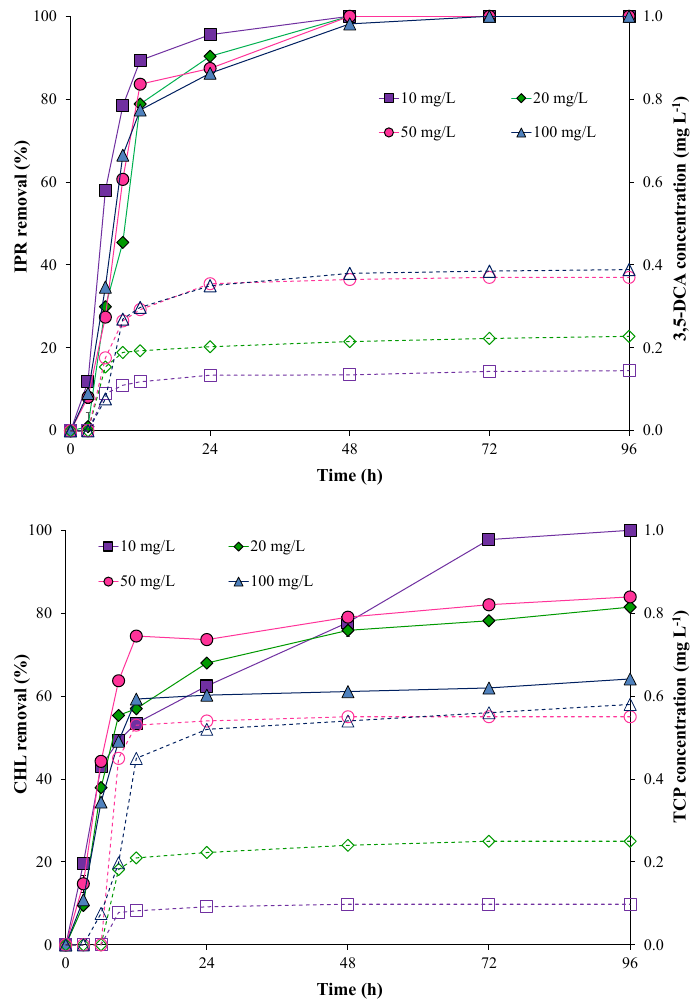
Figure 2. Pesticide removal (symbol filled with a continuous line) and metabolite production (empty symbol with a dotted line) when using the free bacterial consortium in a liquid medium. Iprodione (IPR) and chlorpyrifos (CHL) were added (in mixture) at initial concentrations of 10, 20, 50, and 100 mg L − 1 each.